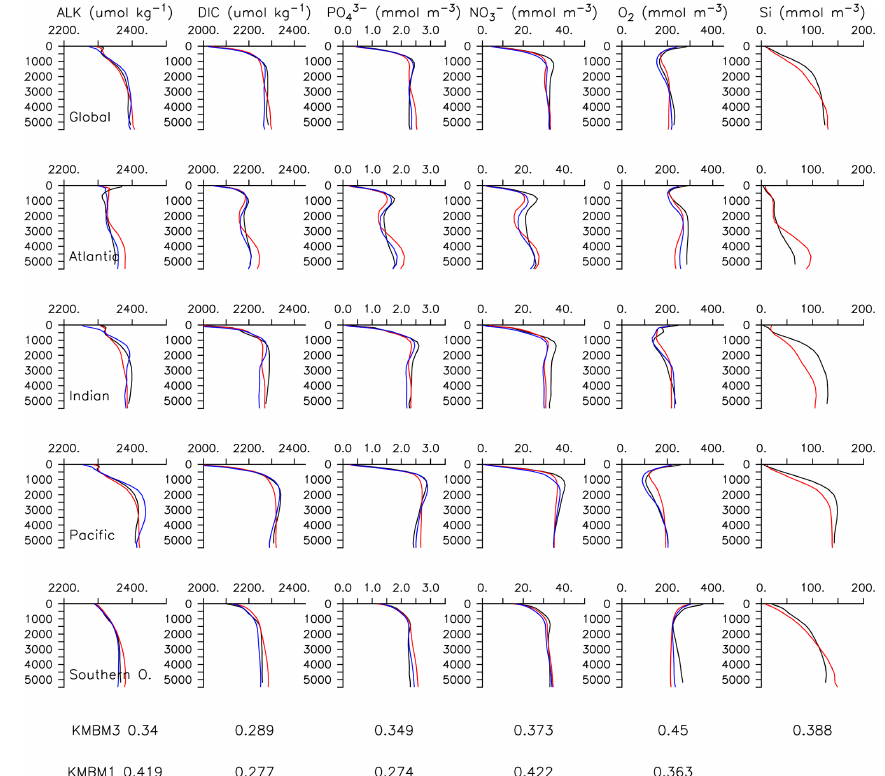
Figure 9. Model global and basin average nutrient and carbon depth profiles at the year 2014 (KMBM3; red lines), compared to model output from the Keller et al. (2012) version (KMBM1; blue lines) and observational data (black lines; Garcia et al., 2014a, b; Key et al., 2015; Lauvset et al., 2016). Global root mean square error is given below each